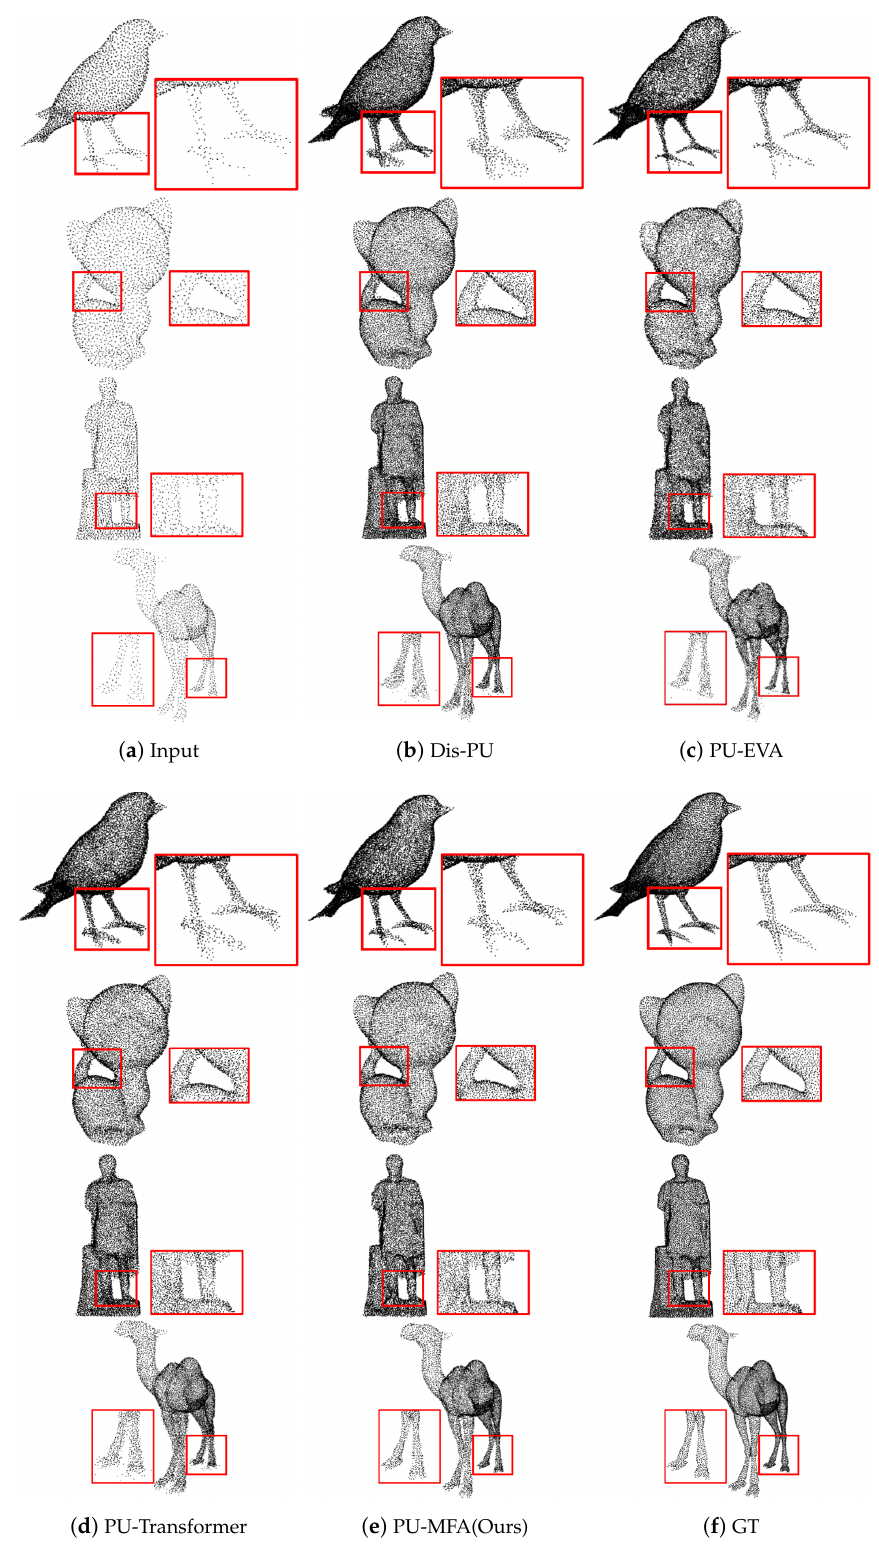
Figure 5. Visualization result of × 4 up-sampling on PU-GAN dataset (tubular